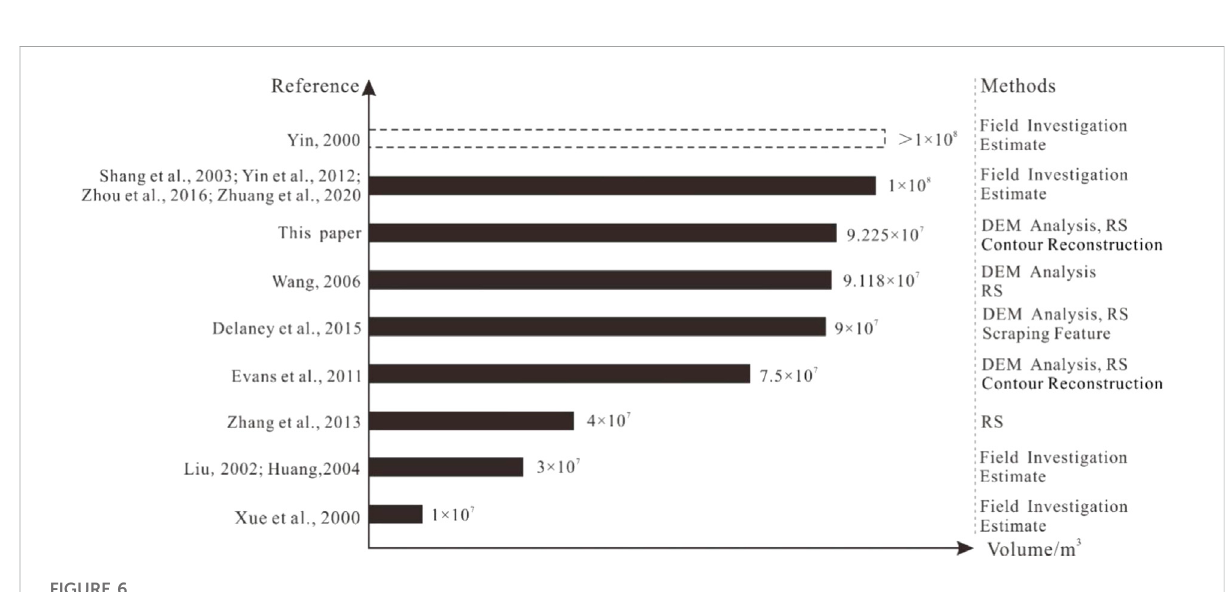
FIGURE 6 Summary of the initial landslide volume of the Yigong landslide in